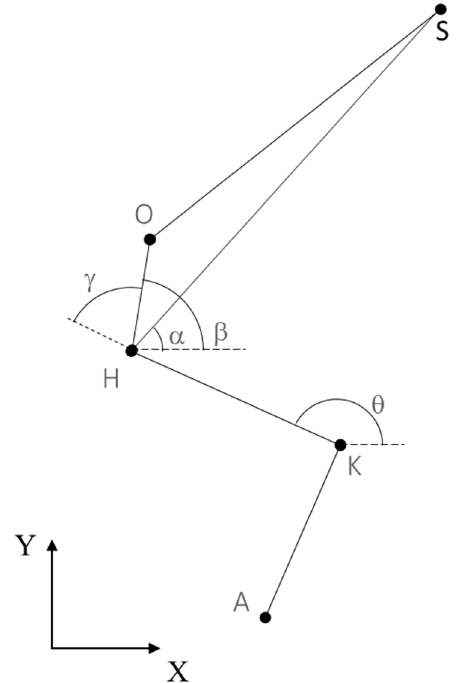
Figure 3. Chaffin’s linked segment model (LSM) (upper arm and forearm are excluded) used to estimate the position of the L5/S1 (O) joint center. A = ankle joint center; K = knee joint center; H = hip joint center; S = shoulder joint center; γ = pelvic rotation angle; β = angle formed by the segment joining H to O with the horizontal axis; α = inclination of the trunk with respect to the horizontal axis; θ = inclination of the thigh with respect to the horizontal axis.